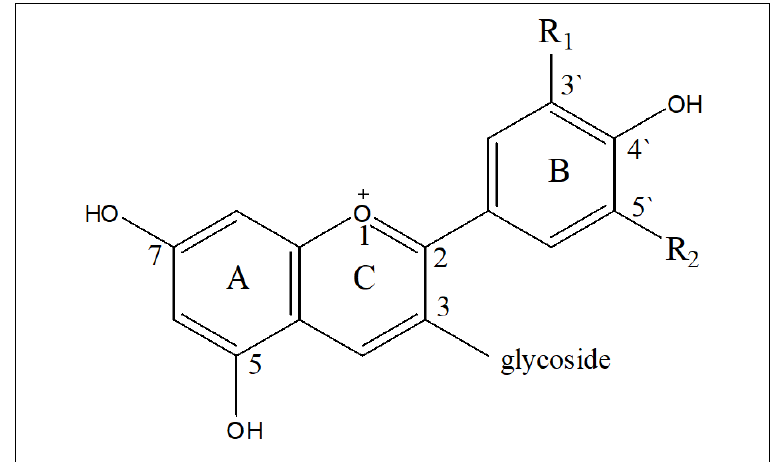
Figure 1: General structure of